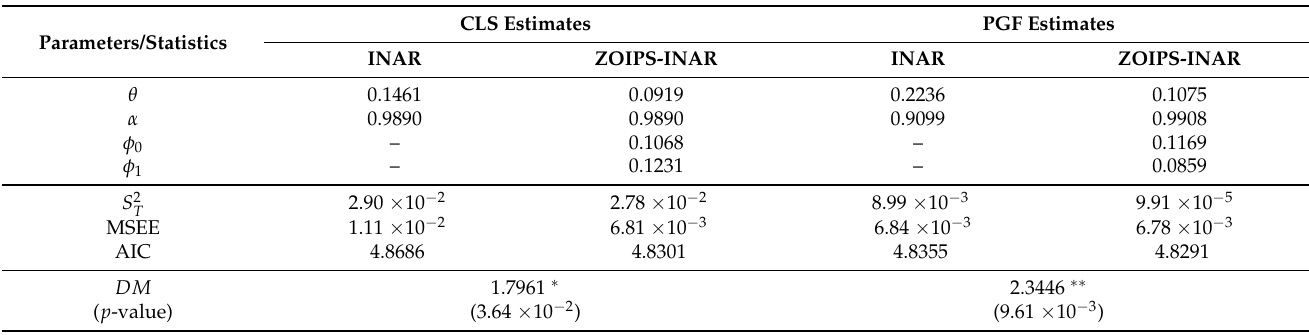
Table 5. Estimated fitting parameters of the considered data with the INAR(1) and ZOIPS-INAR(1) models, along with their goodness-of-fit and predictive statistics. (Geometric distribution is assumed for PS-distributed